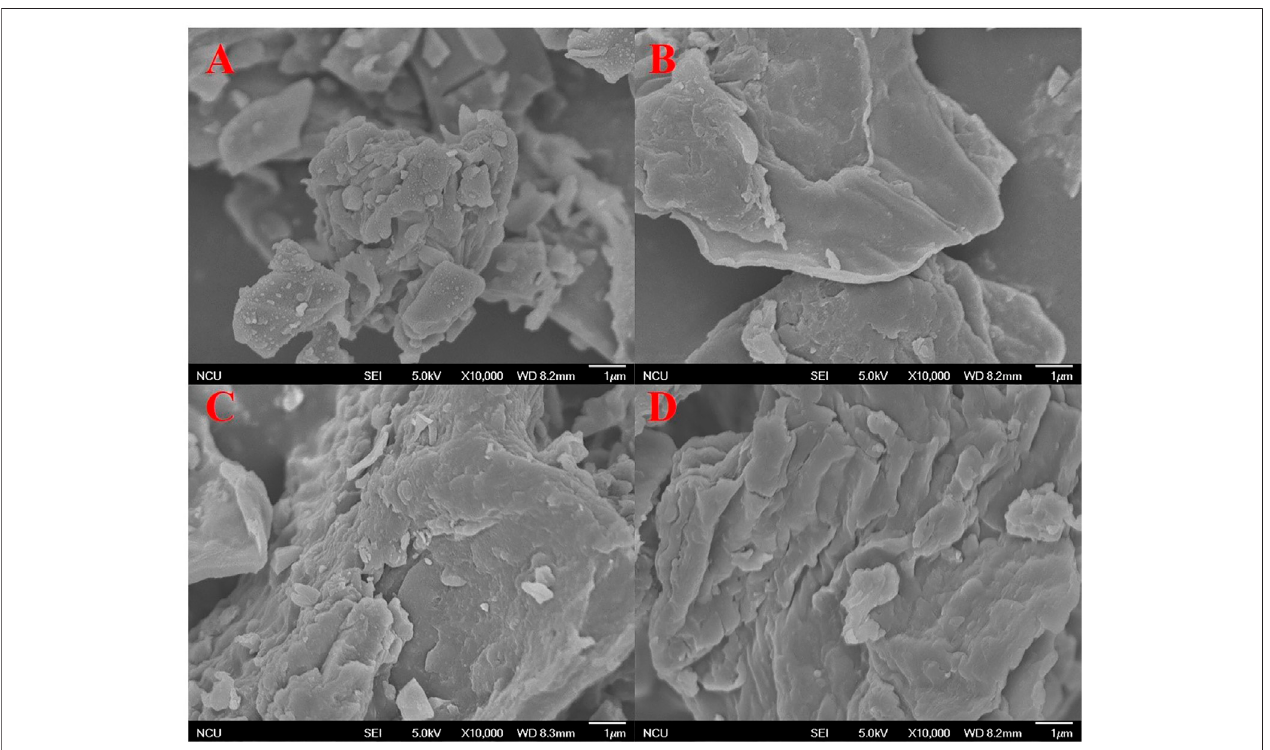
FIGURE 3 | SEM images of biochar treated under different conditions. (A) Untreated – 600 ° C; (B) 1:1 – 600 ° C; (C) 1:2 – 600 ° C; and (D) 1:3 – 600 ° C.